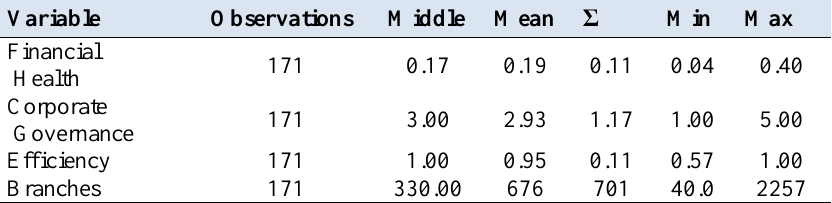
Table 2-1. Results from descriptive statistics of data